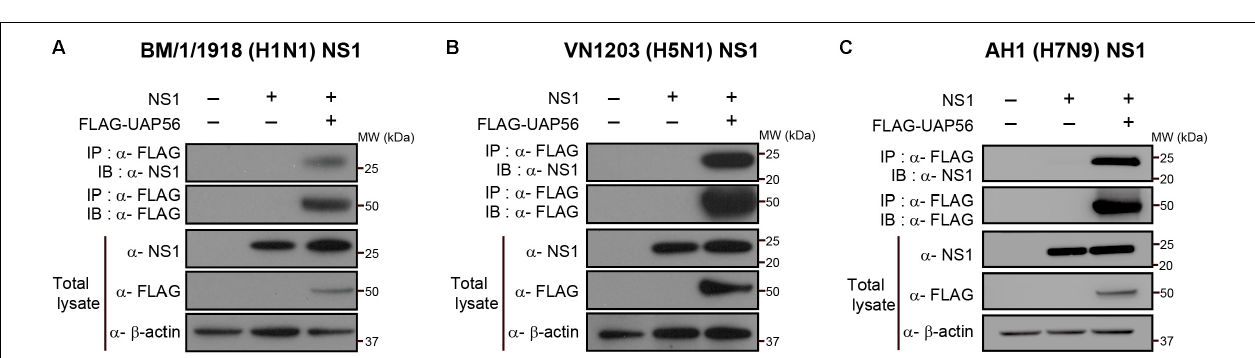
FIGURE 1 | In vitro coprecipitation of NS1 with UAP56 or MxA. (A) In vitro interaction of NS1 with UAP56. HEK293T cells were transfected with protein expression plasmids for WSN-NS1 and/or FLAG-tagged UAP56. At 48 h post-transfection, cells were lyzed and immunoprecipitated (IP) with anti-FLAG antibody. Co-precipitated proteins were analyzed by immunoblotting (IB) with anti-NS1 antibody. (B) In vitro interaction of NS1 with MxA. HEK293T cells were transfected with protein expression plasmids for WSN-NS1 and/or FLAG-tagged MxA. Co-immunoprecipitation and IB were carried out as described in A . (C) Overexpression of MxA does not affect the UAP56–NS1 interaction. HEK293T cells were transfected with plasmids expressing UAP56 and/or FLAG-tagged NS1, and increasing amounts of MxA. Forty-eight hours later, the cells were lyzed and IP with anti-FLAG antibody. Co-immunoprecipitation and IB were carried out as described in A . (D) UAP56–NS1 interaction in influenza A virus-infected cells. HEK293T cells were transfected with pCAGGS-FLAG-UAP56 or a control vector, and infected with WSN virus at a multiplicity of infection (MOI) of one. The cells were harvested and lyzed at the indicated time points post-infection and IP with anti-FLAG antibody. Co-precipitated proteins were analyzed by IB with anti-NS1 antibody; the NP expression levels in the total cell lysate were analyzed as an infection control.